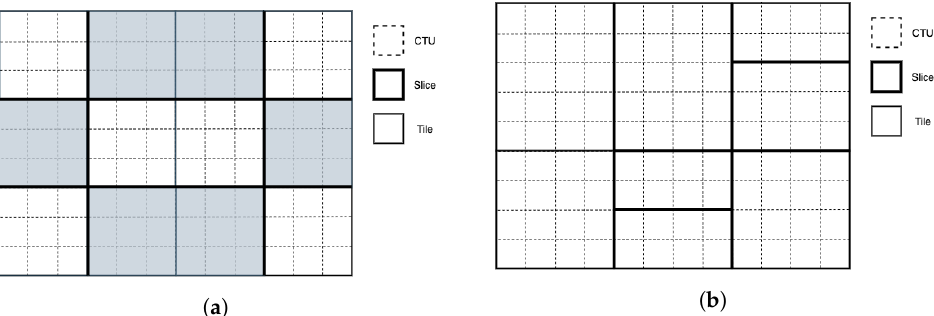
Figure 2. Example of rectangular slice partitioning. ( a ) 12 tiles (4 columns, 3 rows) and 9 slices; ( b ) 6 tiles (3 columns, 3 rows) and 7